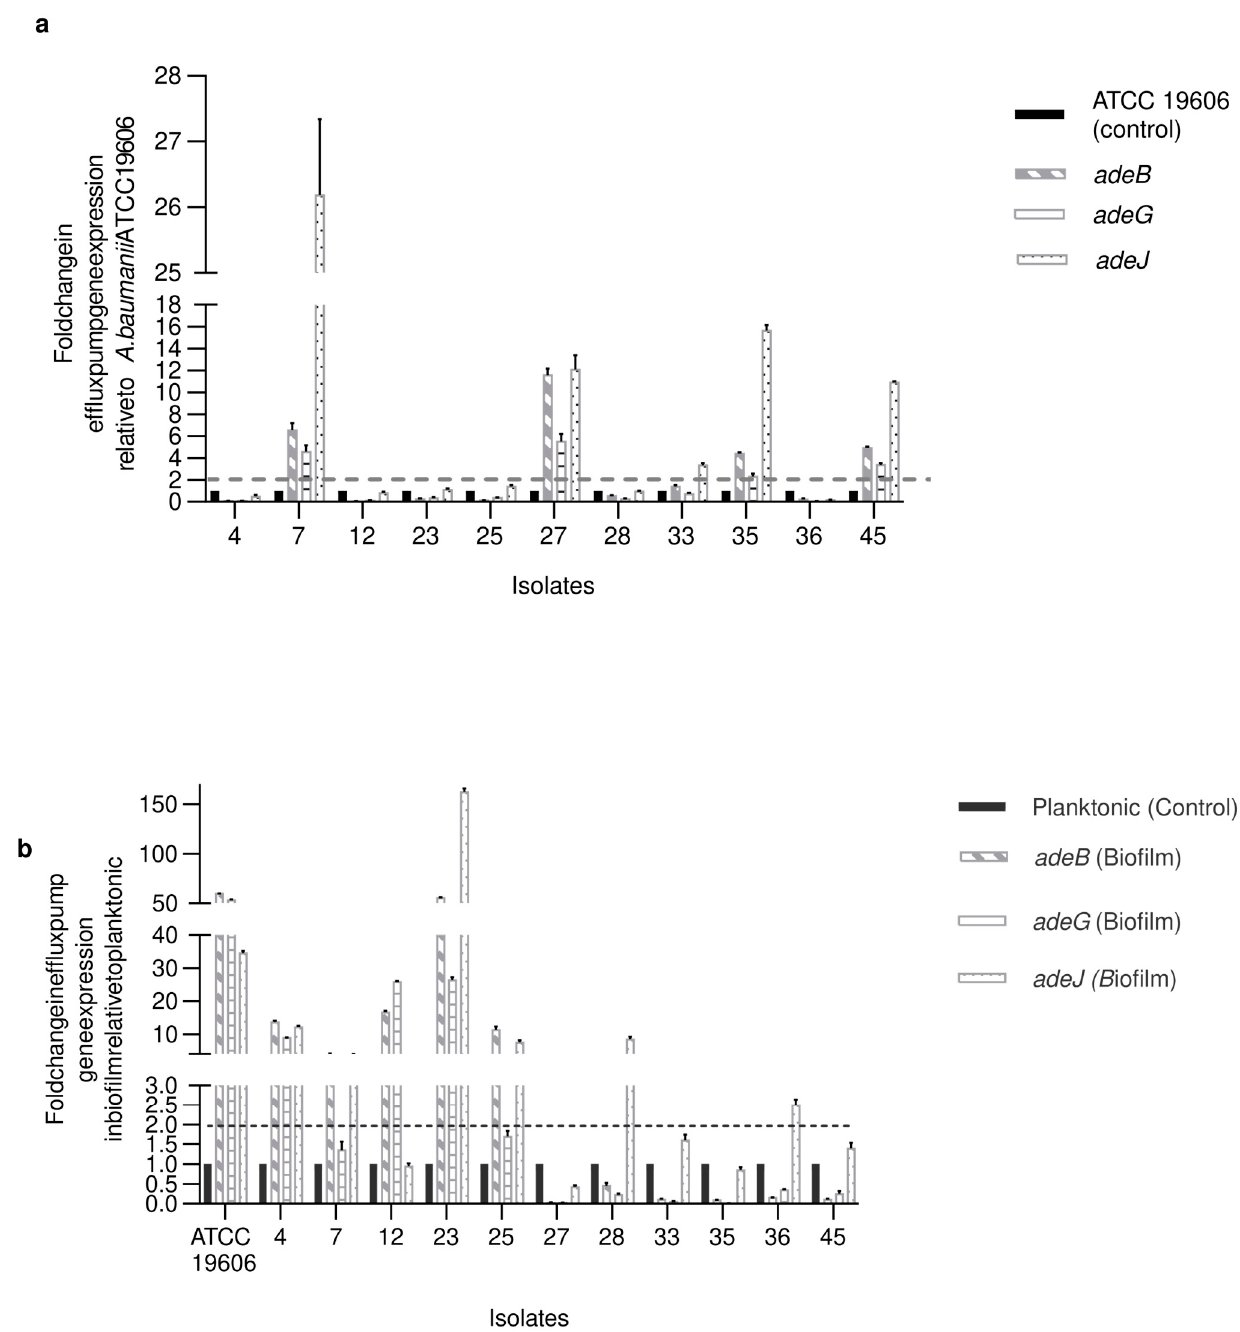
Figure 1. Fold changes in expression of the adeB , adeG , and adeJ genes in A. baumannii isolates. The bars represent relative expression levels of each gene with the corresponding control. ( a ) Expression of isolates in planktonic cells relative to standard strain (ATCC 19606) (control); ( b ) Expression of isolates in biofilm forming cells and standard strain relative to their planktonic cells (control). The error bars represent the standard error of mean (SEM). All values are means ± SEM. 16S rRNA was used as housekeeping gene control. Strong biofilm forming isolate (Standard strain ATCC 19606, 4, 23, 25, 28), moderate biofilm forming isolate (27, 33, 35, 45), weak biofilm forming (7, 12), and non-adherent isolate (36). Dotted line: Change in expression > 2 folds.